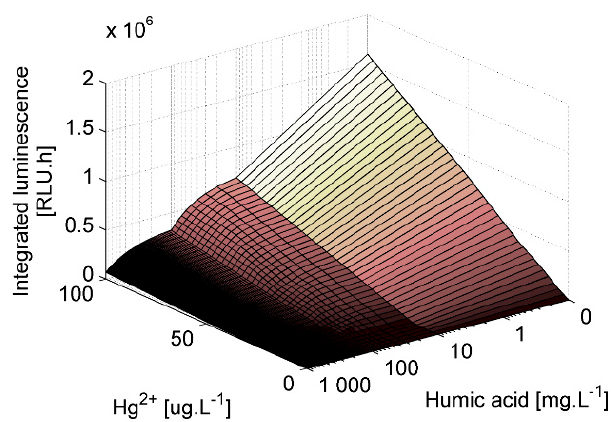
Figure 5. Dependence of integrated luminescence measured in water solutions on humic acids and mercury concentrations (mercury was added in the form of mercury (II) chloride). Table 3. Specific growth rates of E. coli ARL1 in the presence of humic acid and mercury (II) chloride. Specific Growth Rates of E. coli ARL1 (h − 1